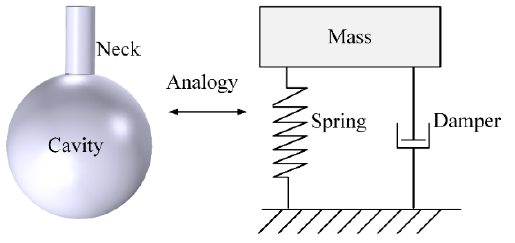
Figure 2. Schematic diagram of a Helmholtz resonator and its mechanical analogy.